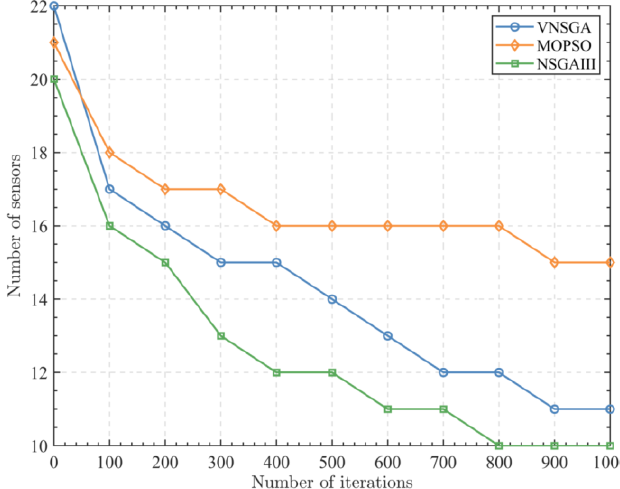
Figure 21. Number of sensors for three algorithms from different iterations for 100 m R s max and 200 m R c max with respect to area A.